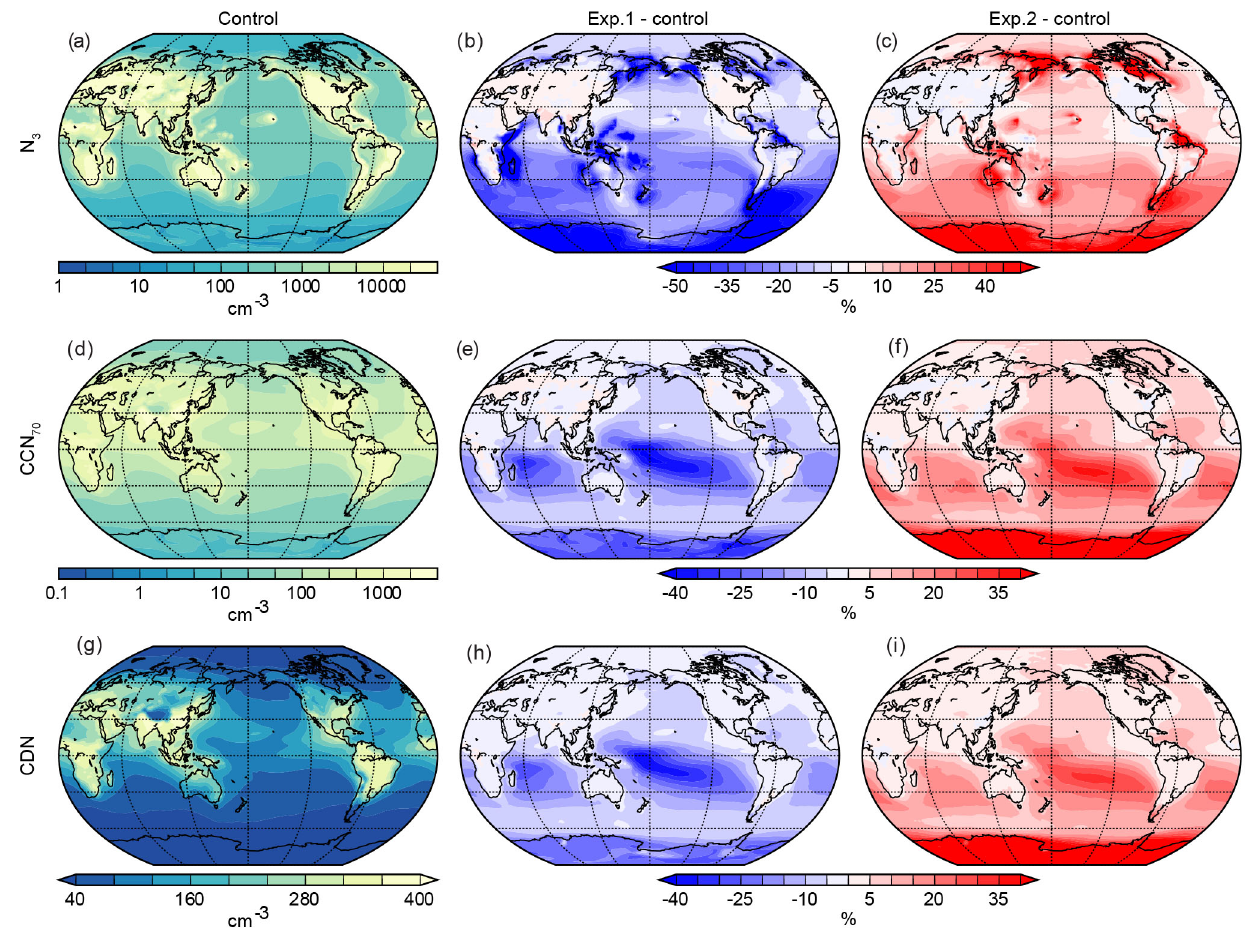
Figure 8. As for Fig. 6, but where (a) , (b) and (c) the number concentration of N 3 (condensation nuclei), (d) , (e) and (f) show the number of cloud condensation nuclei greater than 70nm dry diameter and (g) , (h) and (i) show the cloud droplet number concentration. All units are in cm − 3